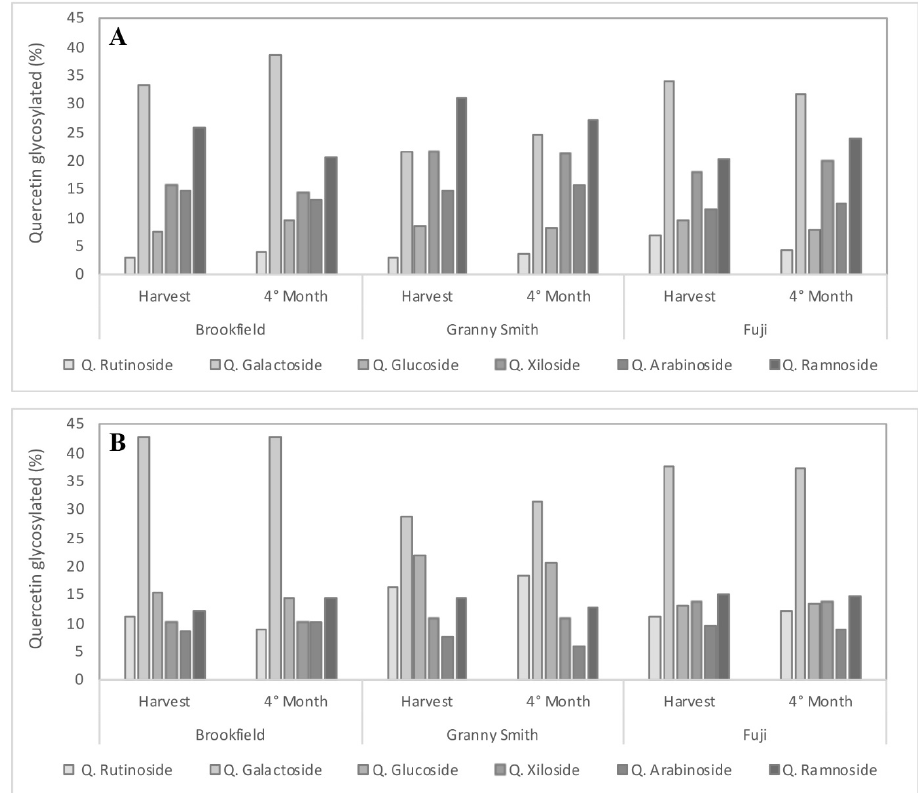
fruit independent of the type of management (conventional or or- ganic). Phenolic compounds and antioxidant capacity decreased in both organically and conventionally grown apples during cold stor- age. However, apples with sunburn damage had higher phenolic com- pound content than those healthy at